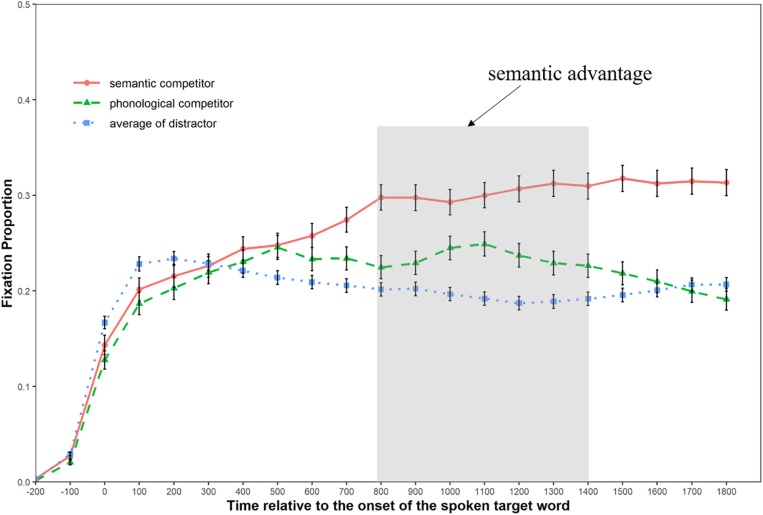
Graph showing the fixation patterns in the replication condition.